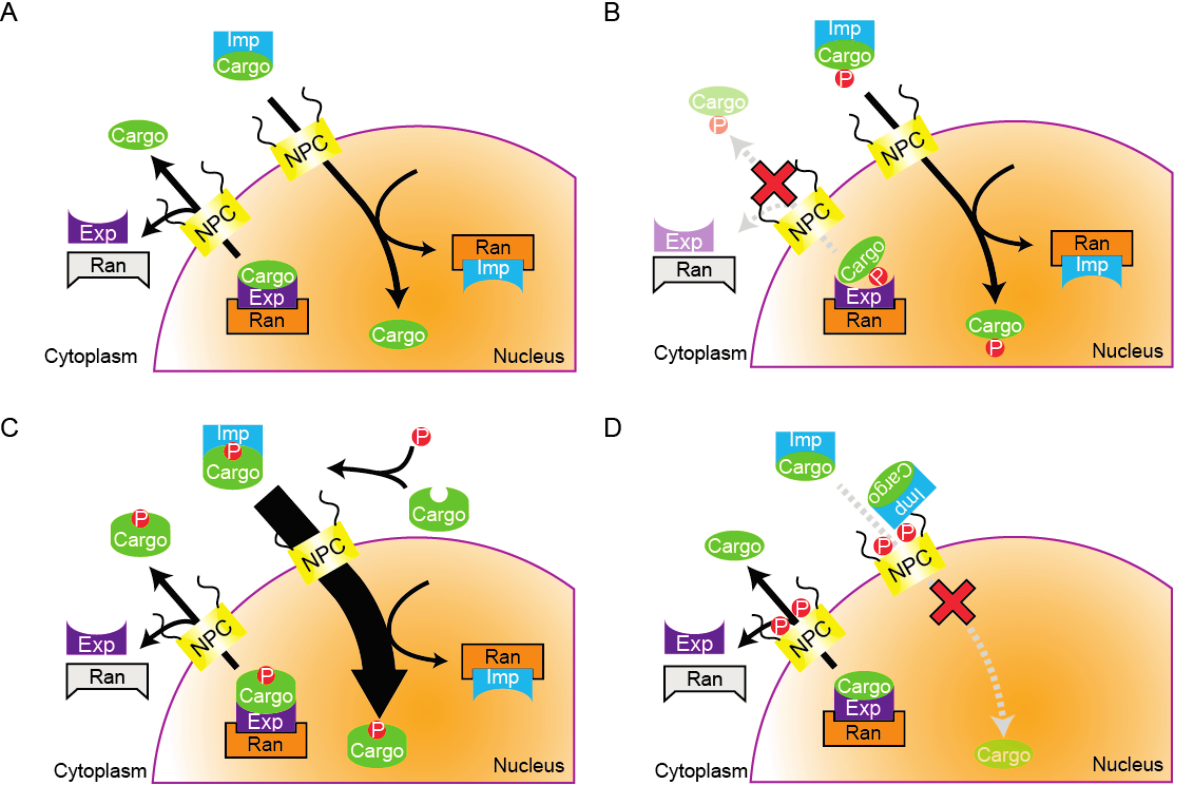
Figure 3. Patterns of temporal regulation of nuclear transport. ( A ) A schematic of the nuclear transport cycle of shuttling proteins. ( B ) An example of the regulation of the nuclear export. Temporal accumulation of cargo proteins can be achieved by shutting off the nuclear export through modification to the NES in cargos. ( C ) An example of the regulation of the nuclear import. Temporal accumulation of cargo here is due to acceleration of import through modification to the NLS of cargos; ( D ) An example of the regulation of nucleoporins (Nups). Phosphorylation of the nuclear pore complex (NPC) component blocks the nuclear import as importin is trapped at the